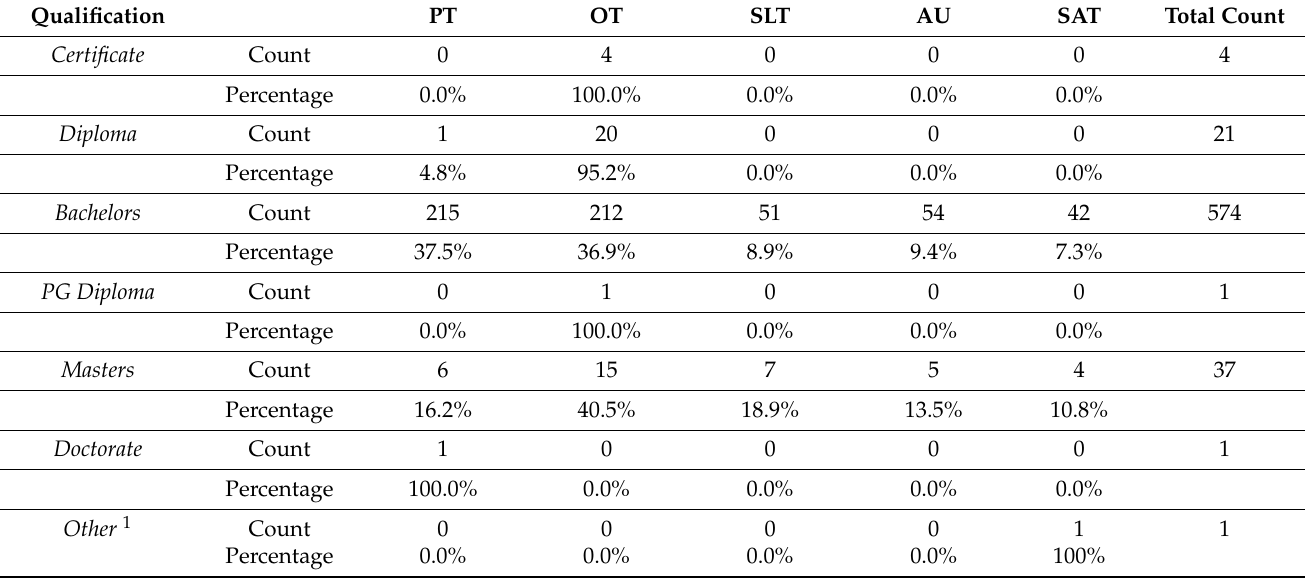
Table 4. Highest level of qualification per profession as derived from the web-based therapist survey, reported as count and percentage within each qualification.